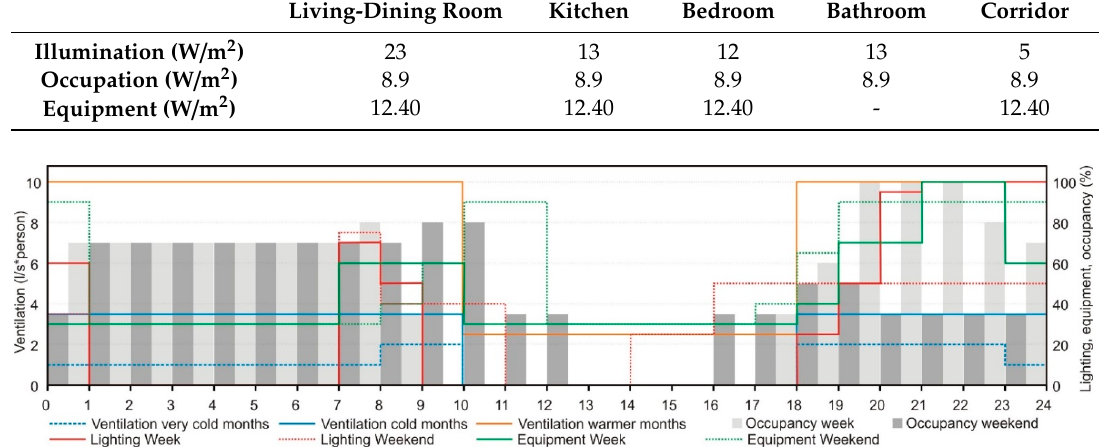
Table 4. Internal heat loads for the models.